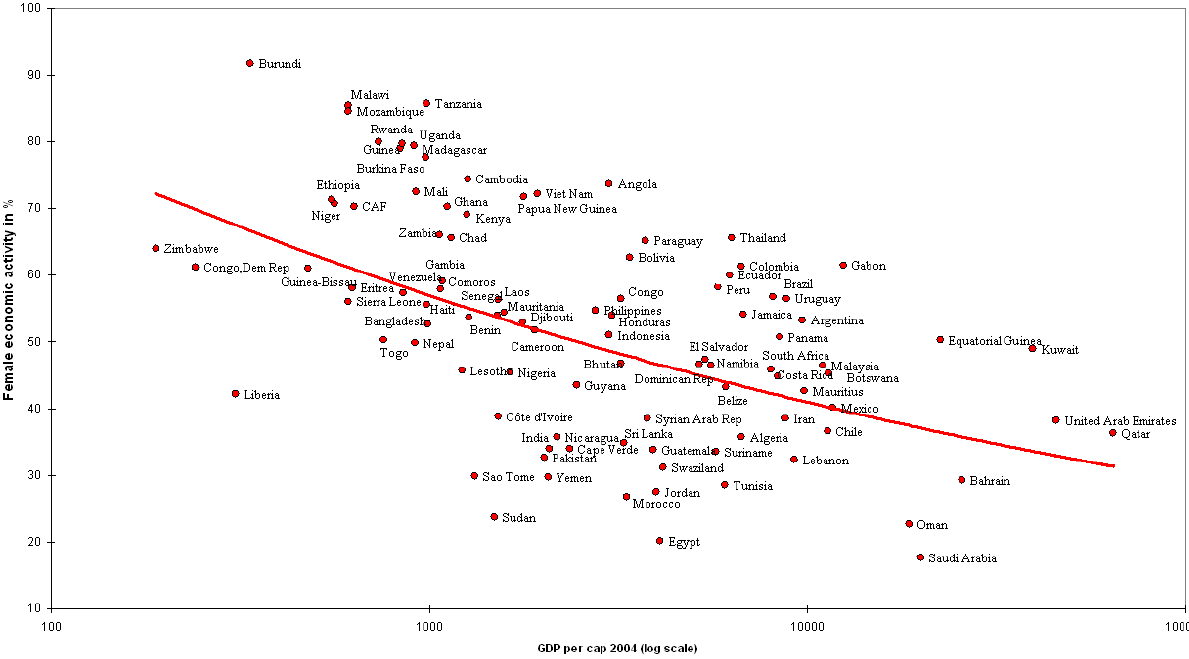
Fig. B2. Female economic participation versus income per capita, distribution and trendline for